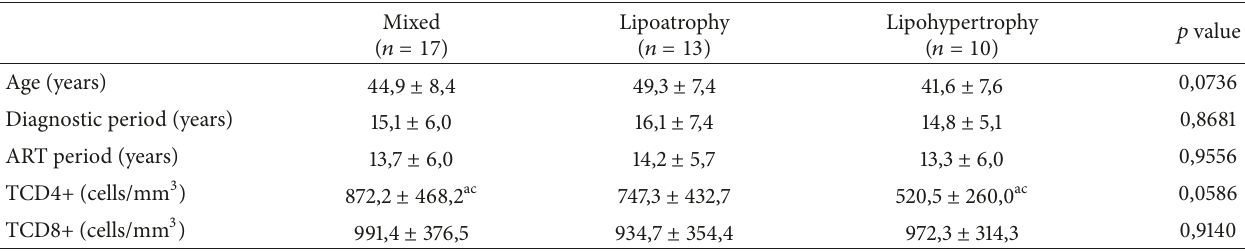
Table 5: Clinical-immunological people living with HIV/AIDS profile with clinical HIV-associated lipodystrophy syndrome diagnosis separated by HIV-associated lipodystrophy syndrome subtypes.